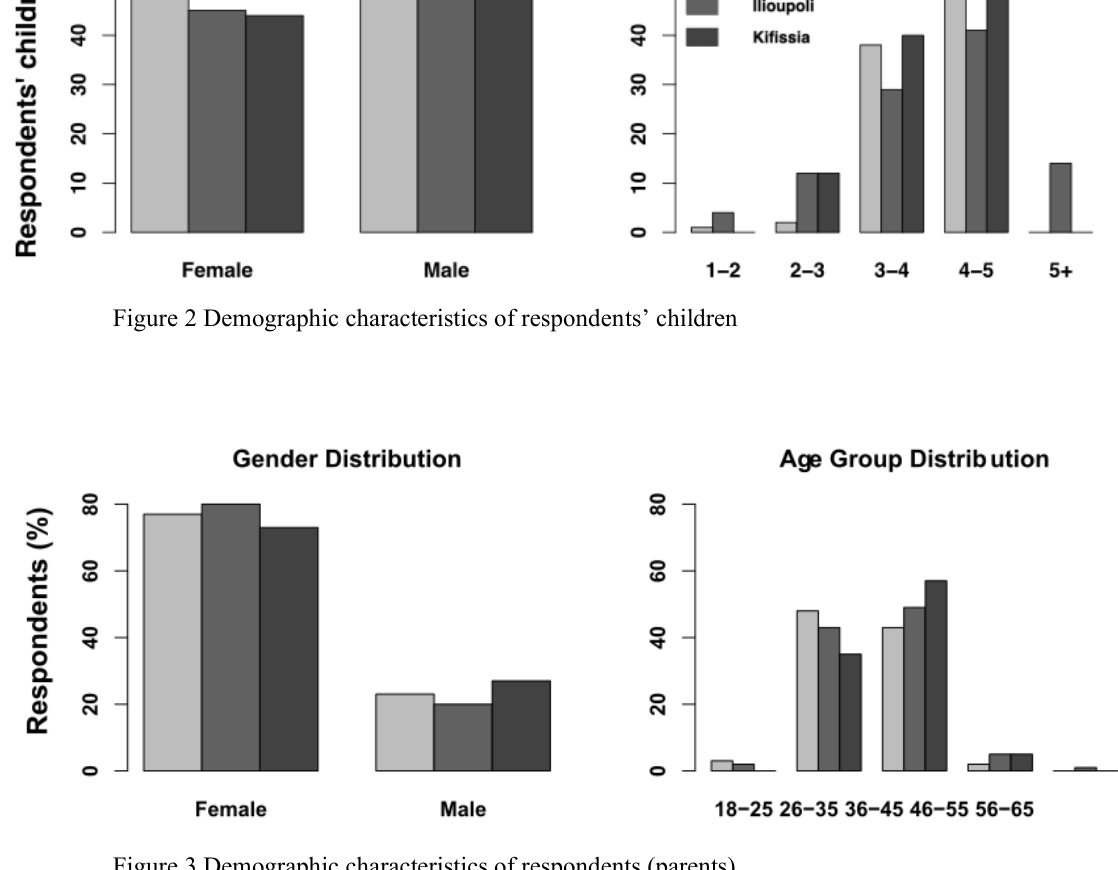
Figure 3 Demographic characteristics of respondents